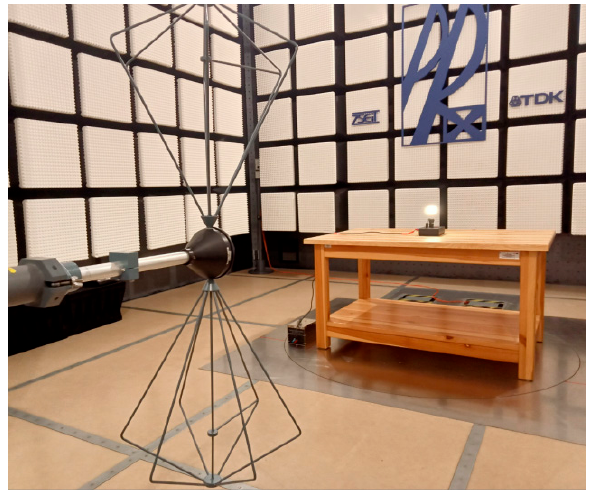
Figure 1. Test stand for measuring the radiated disturbance emissions generated by the LED lamp under test in the frequency range of 30 to 300 MHz using the SAC method.